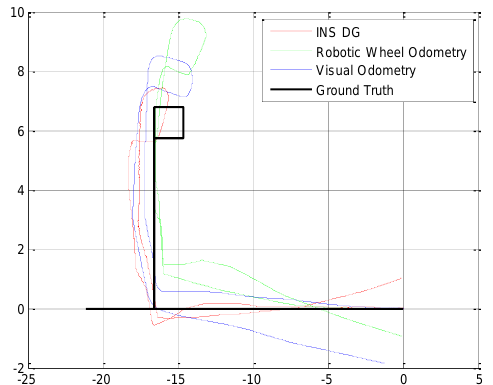
Figure 6. The comparison between indoor positioning solutions and ground truth in experiment 1